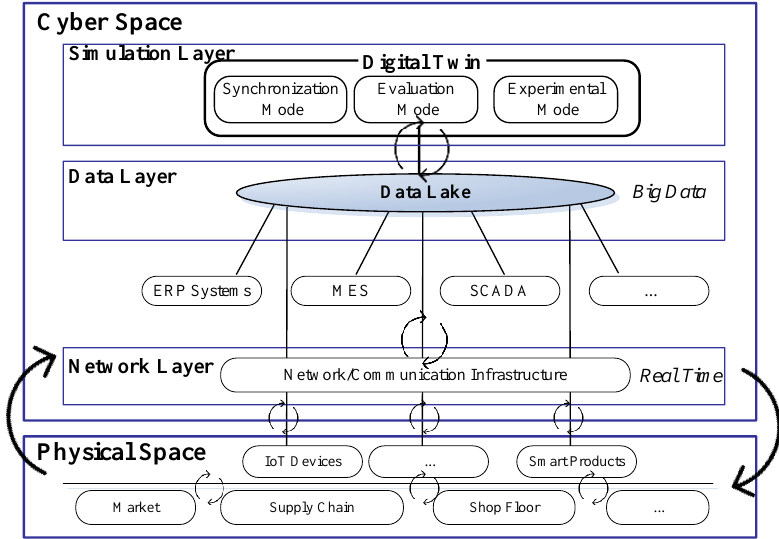
Figure 1. Digital twin with a cyber-physical system.